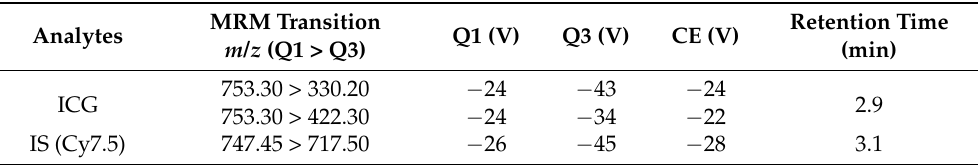
Table 1. Data acquisition and quantification were performed by using LabSolutions Version 5.8 (Shimadzu Scientific, Inc.). Table 1. Summary of the MS/MS parameters: precursor ion, product ions, voltage potentials (Q1 and Q3), and collision energy (CE) for ICG and